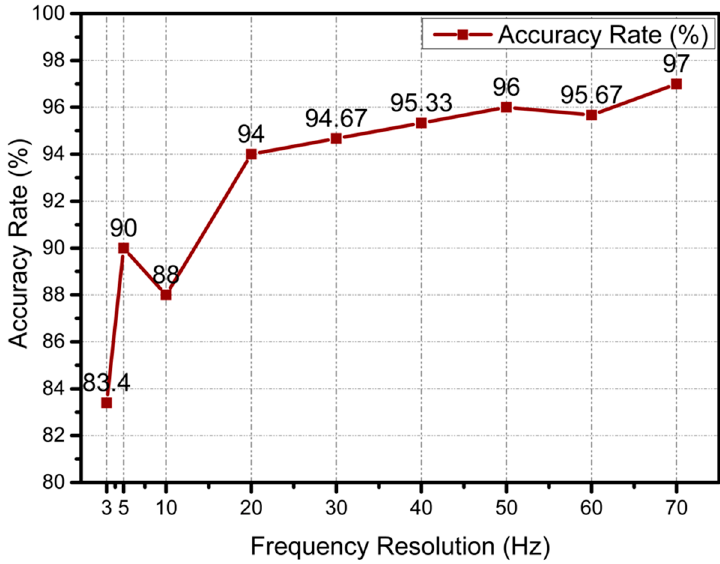
Figure 10. The recognition accuracy rate at different frequency resolution in high frequency range.